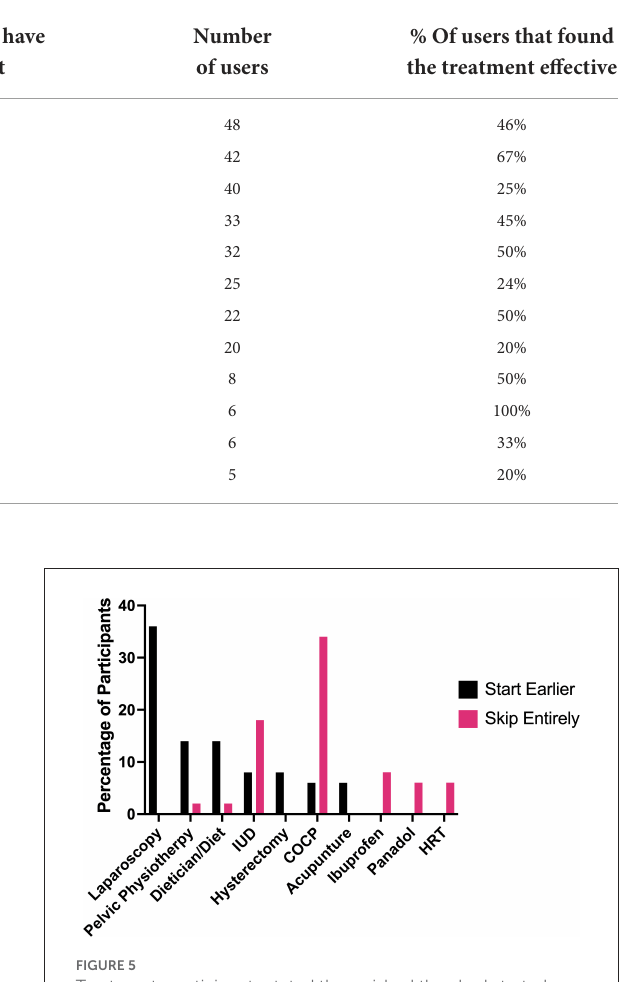
TABLE 2 Distribution of participants that used a treatment and considered that treatment effective.